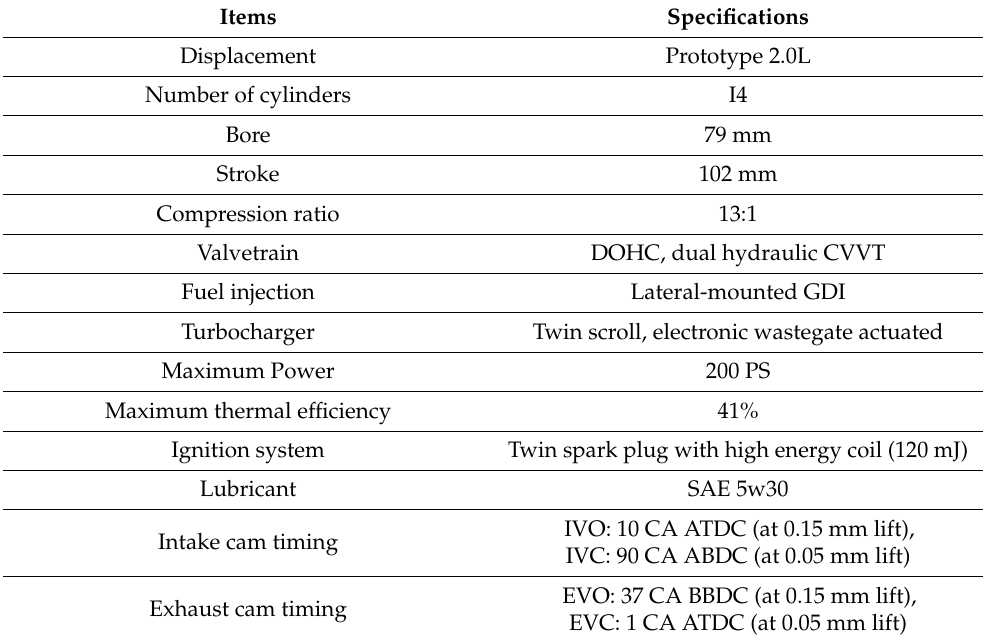
Table 1. Specifications of the Test